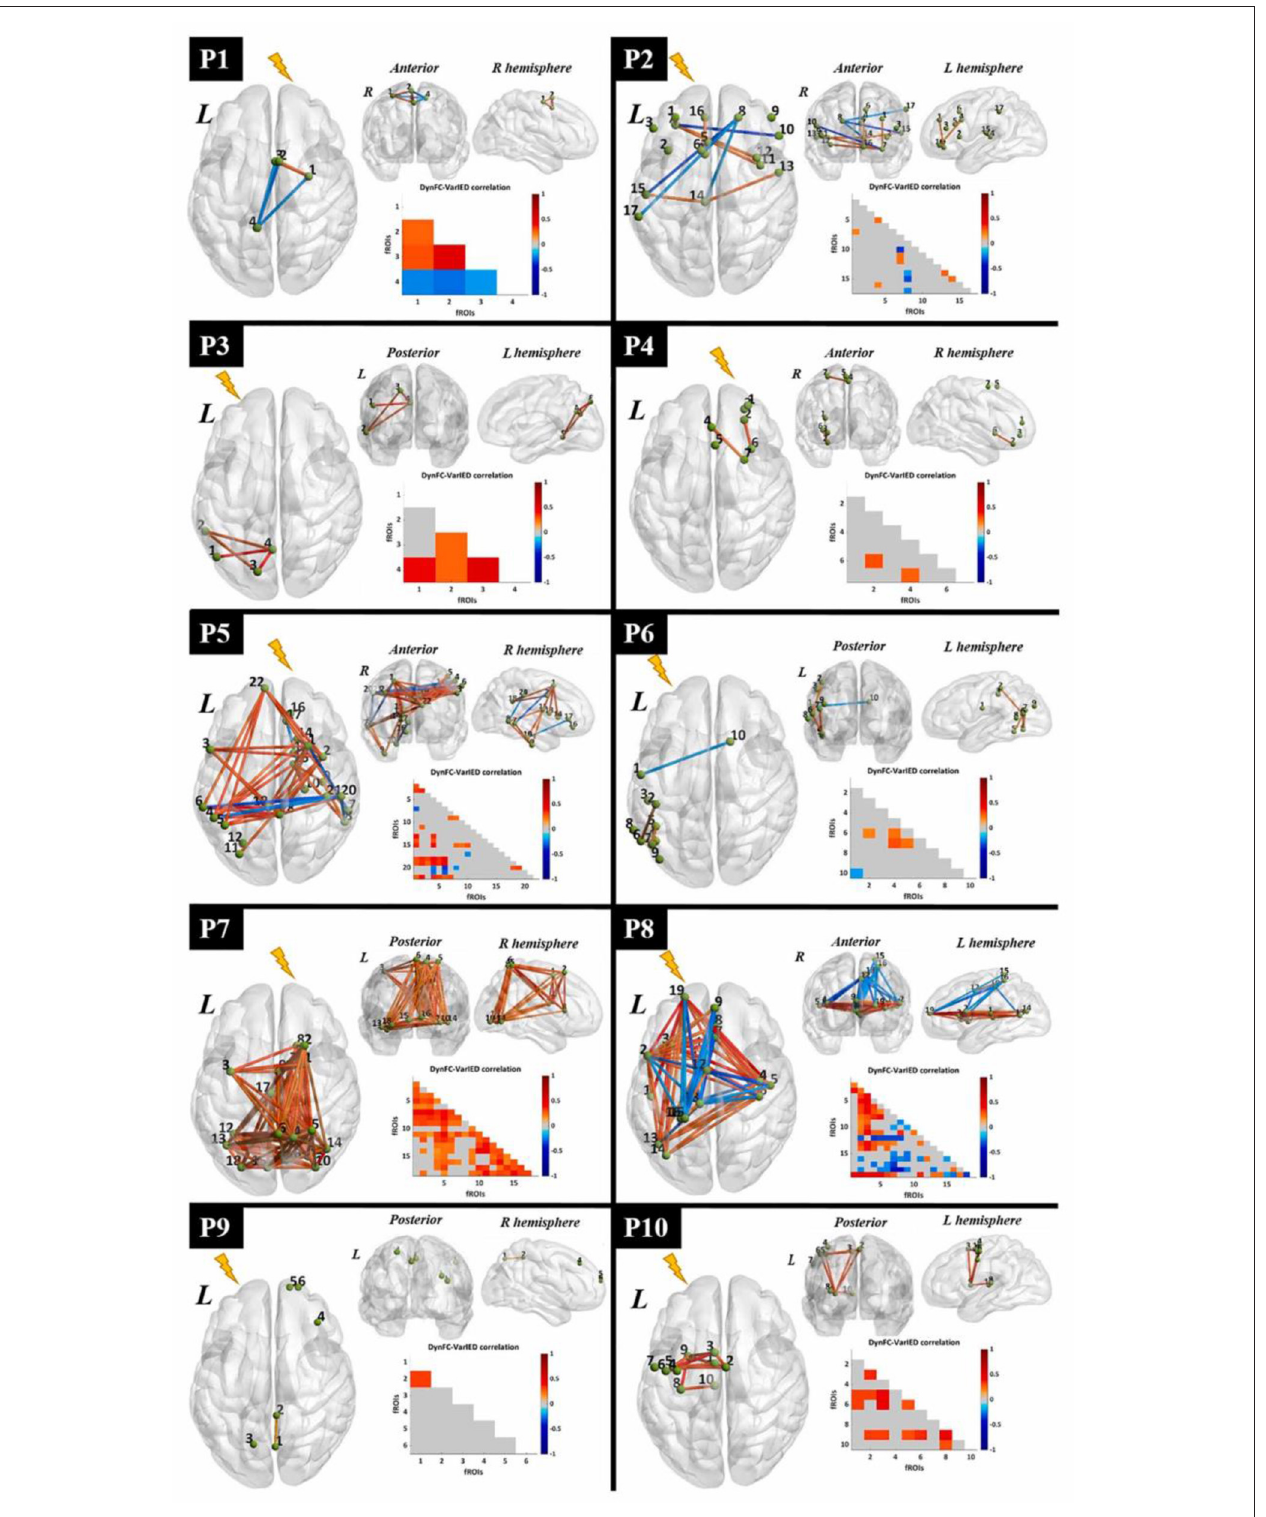
FIGURE 11 | Visualization of dynamic epileptic subnetwork. For each patient, the dynamic epileptic subnetwork is shown in the form of a brain graph in axial, coronal, and sagittal views. Green spheres of equal size represent fROIs, labeled with a number indicating their statistical relevance in the epileptic network. The strength of significant connections is color-coded according to a global color bar scaled in the range [ − 1, 1]. The dynamic epileptic subnetwork is also reported in the form of a lower triangular correlation matrix with equivalent color-code. The lightning bolt indicates the epileptogenic hemisphere for each patient. L, left; R, right (131).